Question: What kind of plot is shown here?
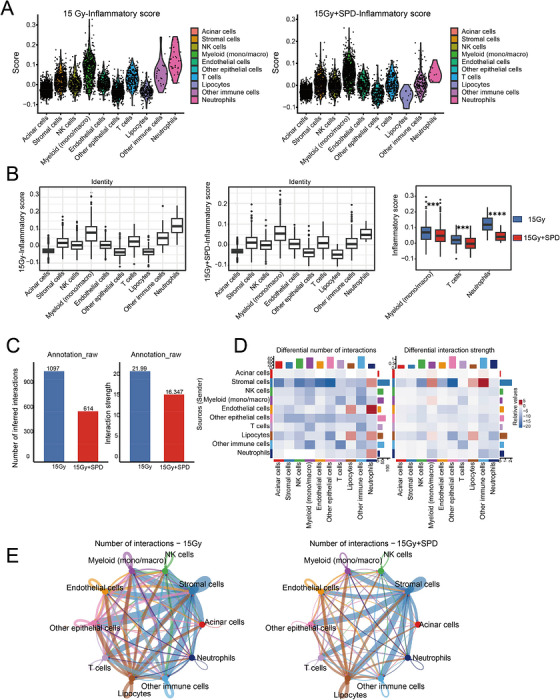
Answer: box